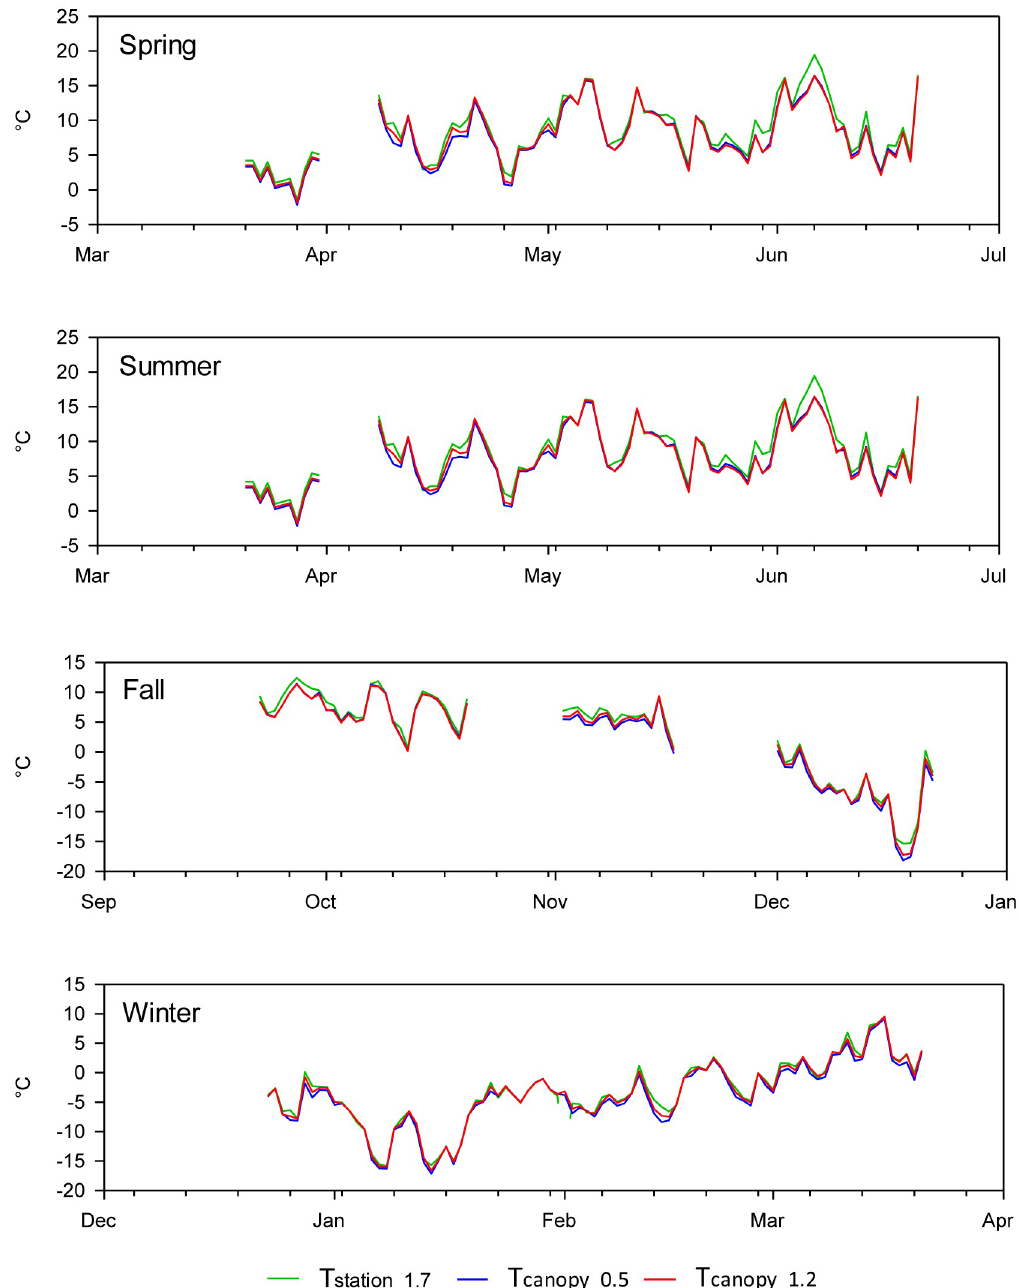
Fig 4. Time series of daily minimum air temperature measured between March 22, 2016, and March 21, 2017, at the weather station (T station_1.7 ), and within the vineyard canopy at a height of 0.5 m (T canopy_0.5 ) and 1.2 m (T canopy_1.2 ) above the ground